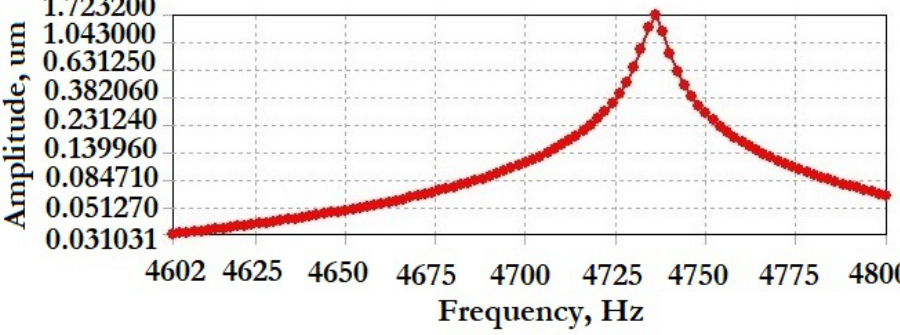
Figure 22. Calculated amplitude–frequency response of the